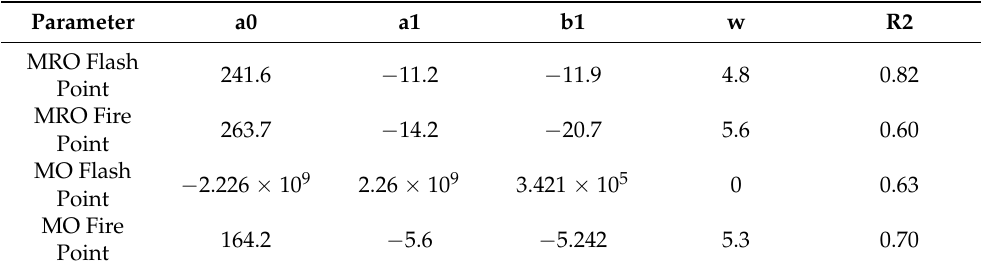
Table 9. Factors associated with the predicted Fourier distribution function of MRO with 95%